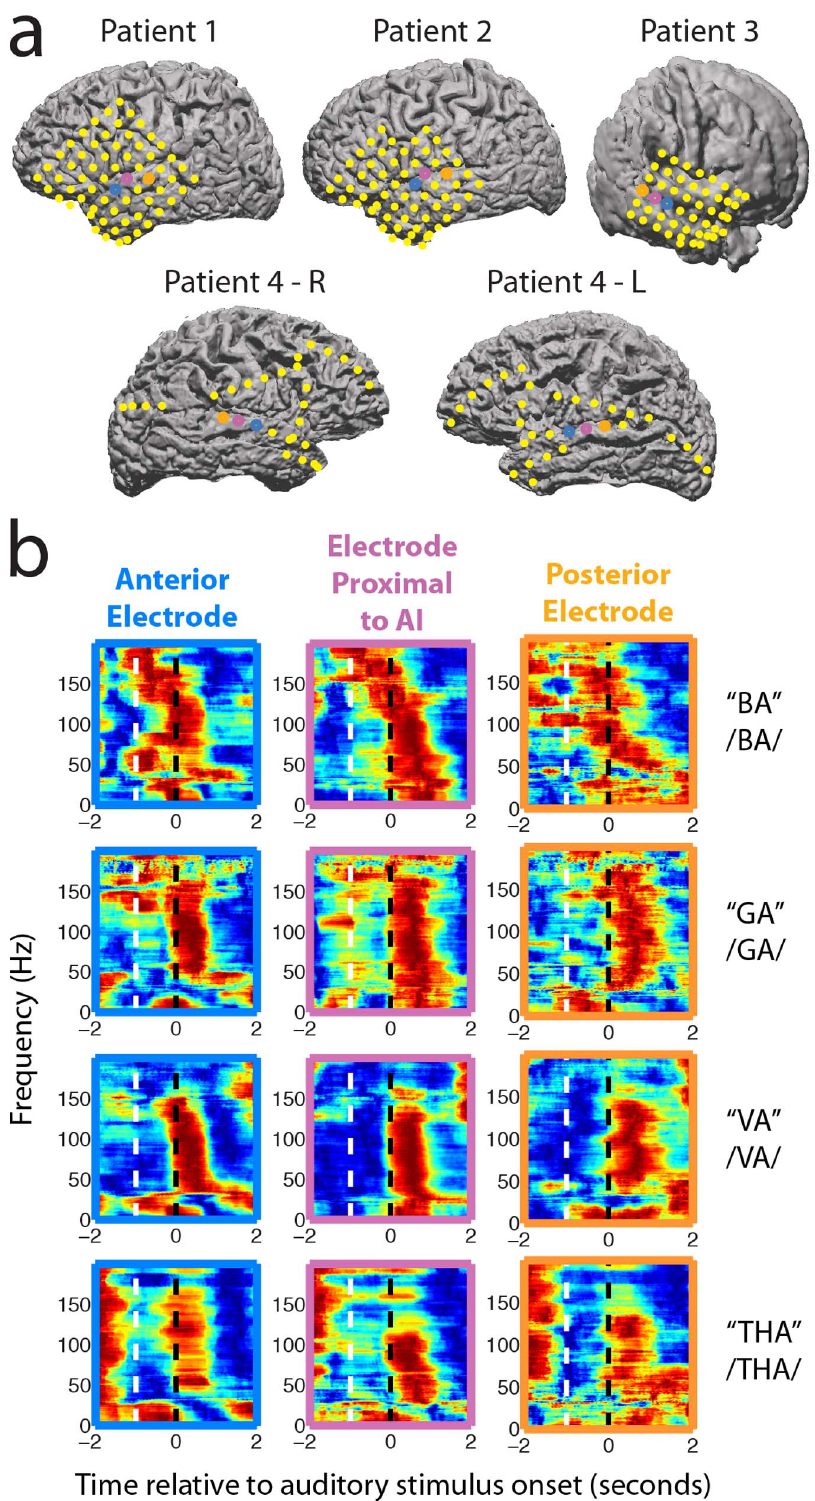
Figure 2. Electrode locations and responses to auditory stimuli on STG electrodes. a, Electrode locations for five hemispheres in four patients. Yellow dots indicate electrode placements we did not use for analyses. Electrodes used for analysis have been color coded. Blue represents the anterior electrode, pink represents the electrode proximal to AI, and orange represents the posterior electrode. b, Representative neural responses for each phoneme on three STG electrodes. White dashed lines indicate the start of the video. Black dashed lines indicate the start of the audio. Responses are outlined to match their respective electrode locations.